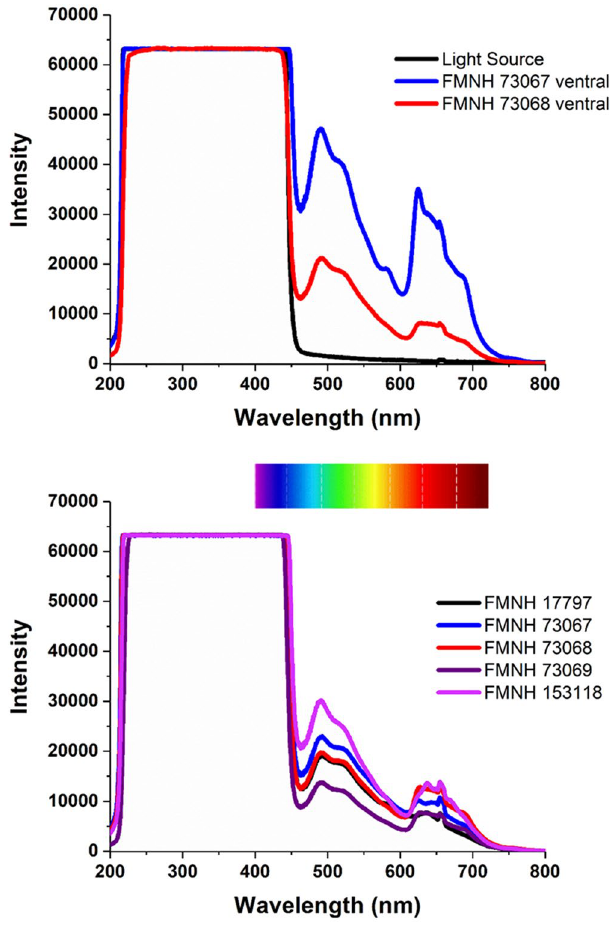
Figure 2. Spectra of biofluorescence observed in East African springhare. (Top panel) Spectra of biofluorescence on the ventral side of two different P. surdaster specimens (red and blue lines) in comparison to the spectrum of the light source taken against a diffuse reflectance standard (black line). (Bottom panel) Spectra of biofluorescence from the dorsal side of five different P. surdaster specimens. Peaks in the visible range (400–750 nm) represent